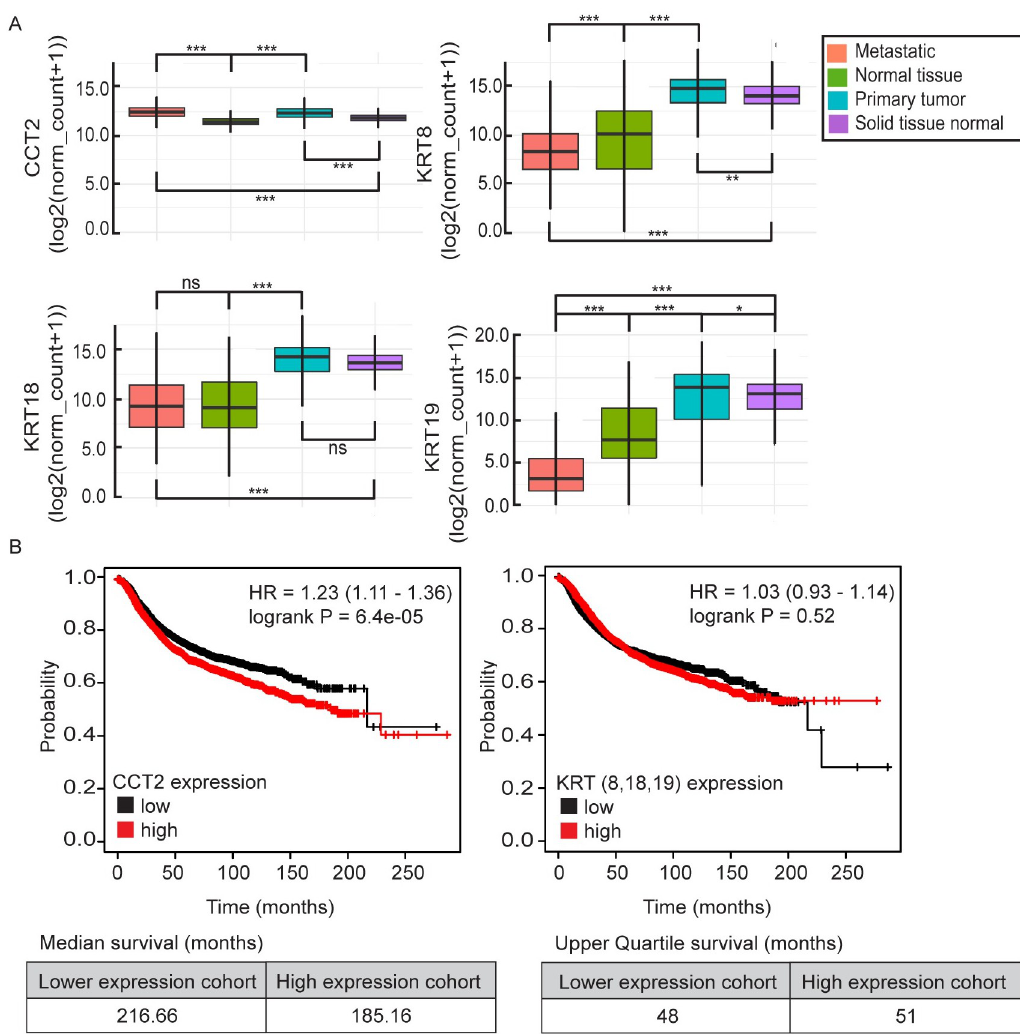
Fig 1. Bioinformatic and histological analysis of CCT2 in cancer patients. (A) UCSC Xena analysis from “TCGA, TARGET, GTEx” dataset (n = 17,200) comparing mRNA expression of CCT2 , KRT8 , KRT18 , and KRT19 in metastatic tissue (orange), normal tissues/GTEx (green), primary tumor (blue), and solid tissue normal/TCGA (purple). � = p < 0.05, �� = p < 0.005, ��� = p < 0.0001. (B) KMplotter analysis of overall survival (OS) with low vs. high CCT2 mRNA expression and low vs high mRNA expression of the mean of KRT8 , KRT18 , and KRT19 combined in breast cancer patients; n = 4,929. Hazard ratios (HR) and log- rank p-values, as calculated by kmplot.com software, are listed on the